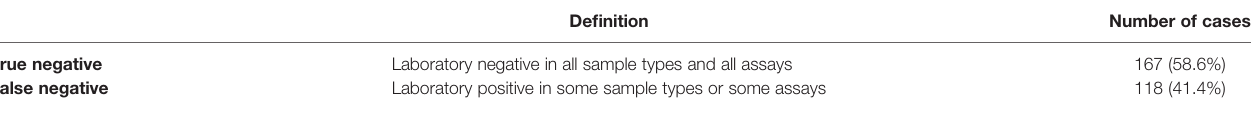
TABLE 2 | Classi fi cation of true negative and false